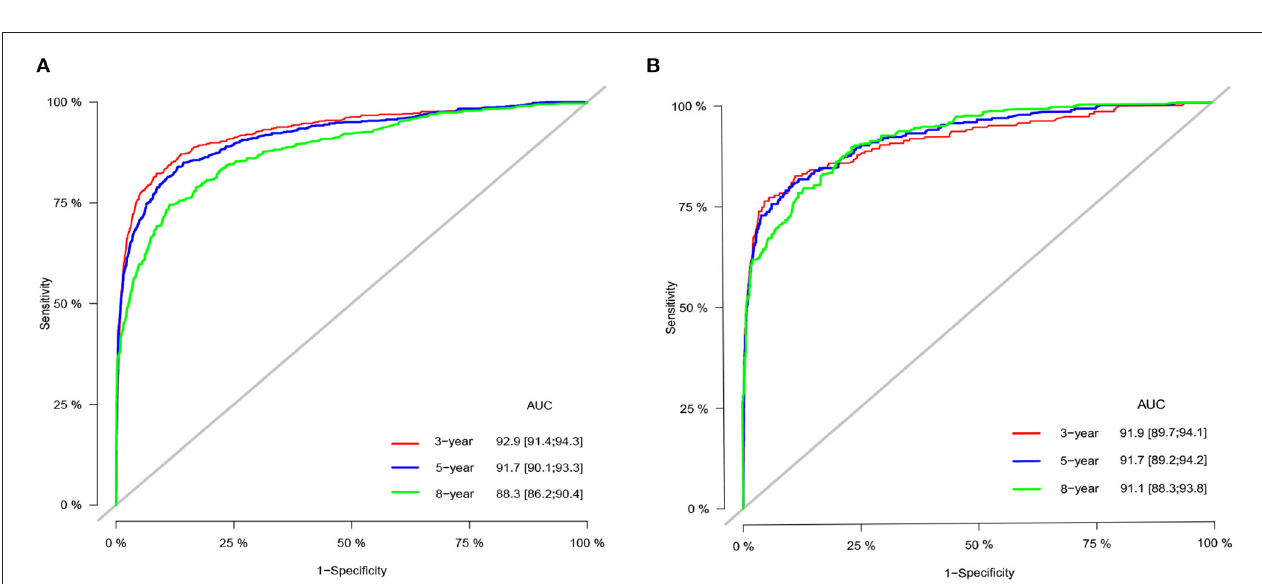
FIGURE 4 | AUC for predicting 3-, 5-, and 8-year CSS in the training set (A) and validation set (B) .